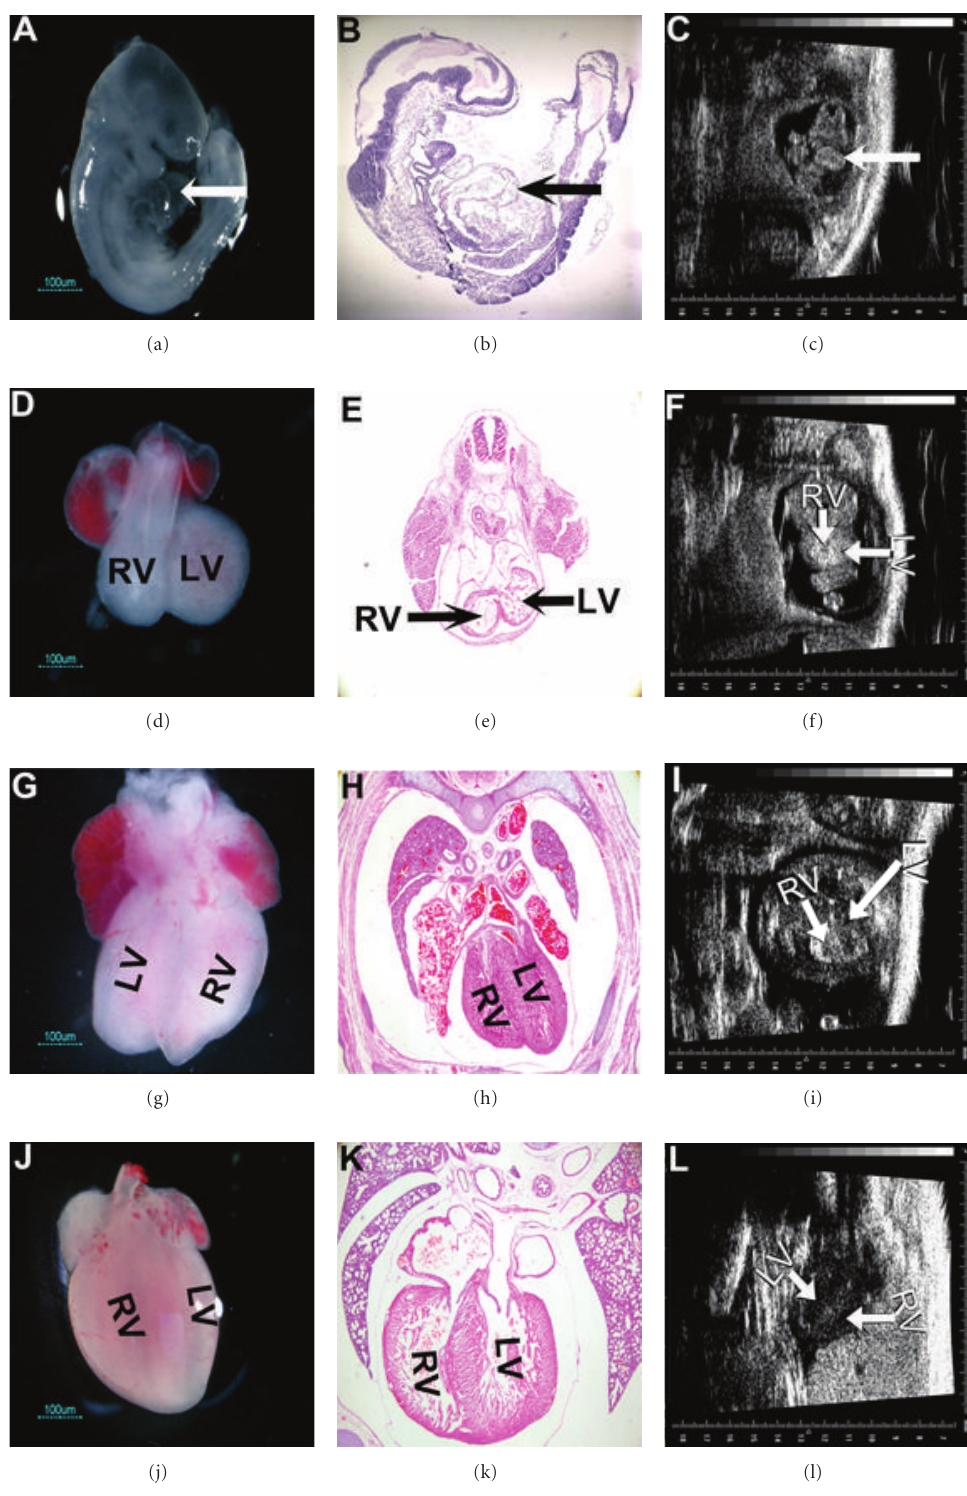
Figure 5: Echocardiographic observations on embryonic mouse heart during the development. Echocardiographic images obtained on embryonic mice from E8.5 to E17.5 ((c), (f), (i), and (l)) are compared with the gross anatomic observations ((a), (d), (g), and (j)) and histological analyses ((b), (e), (h), and (k)) at the same developmental times. The linear heart tubes observed on mouse embryos at day E8.5 are indicated by an arrow ((a), (b), and (c)). RV, right ventricle; LV, left